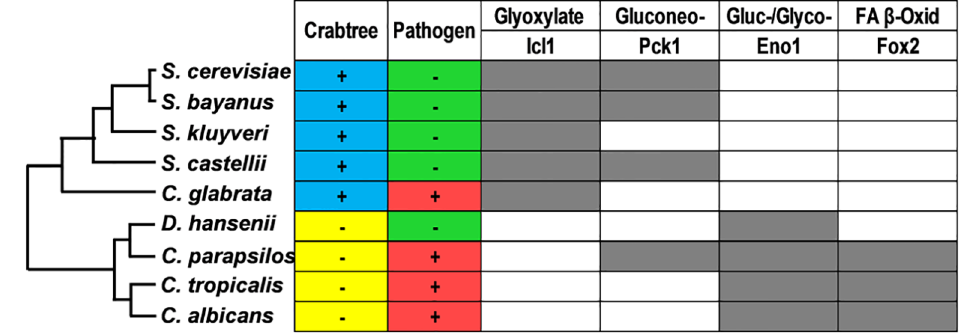
Fig 2. Evolutionary rewiring of metabolic ubiquitination targets across yeast species. The phylogenetic tree of the Candida and Saccharomyces species analysed was generated by aligning ITS sequences using ClustalW. The in silico prediction of ubiquitination sites was performed using Ubpred (www. ubpred.org) [32] on the metabolic enzymes listed in S1 Table in the supplementary information: grey, the presence of at least one high confidence ubiquitination site; red, human pathogen; green, not a human pathogen; blue, Crabtree positive yeast; yellow, Crabtree negative